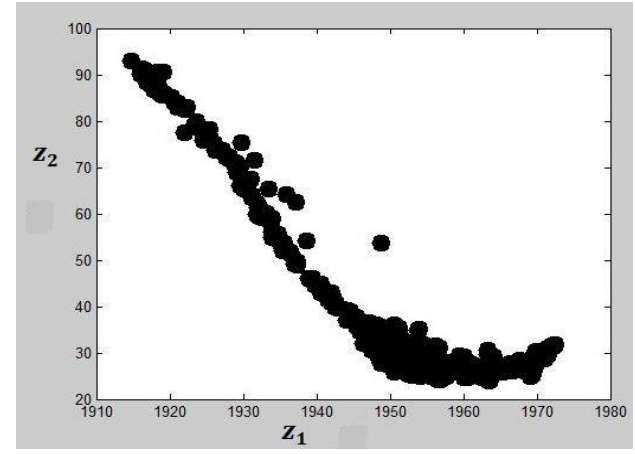
Fig. 10. The Pareto frontiers of quality towards the delivery